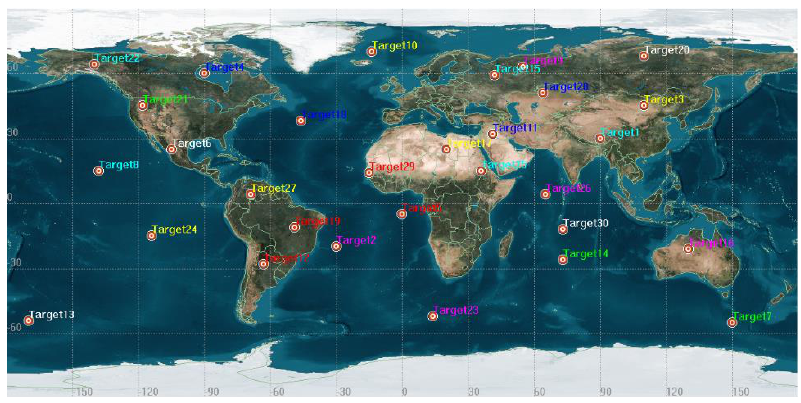
Figure 2. Point target distribution.